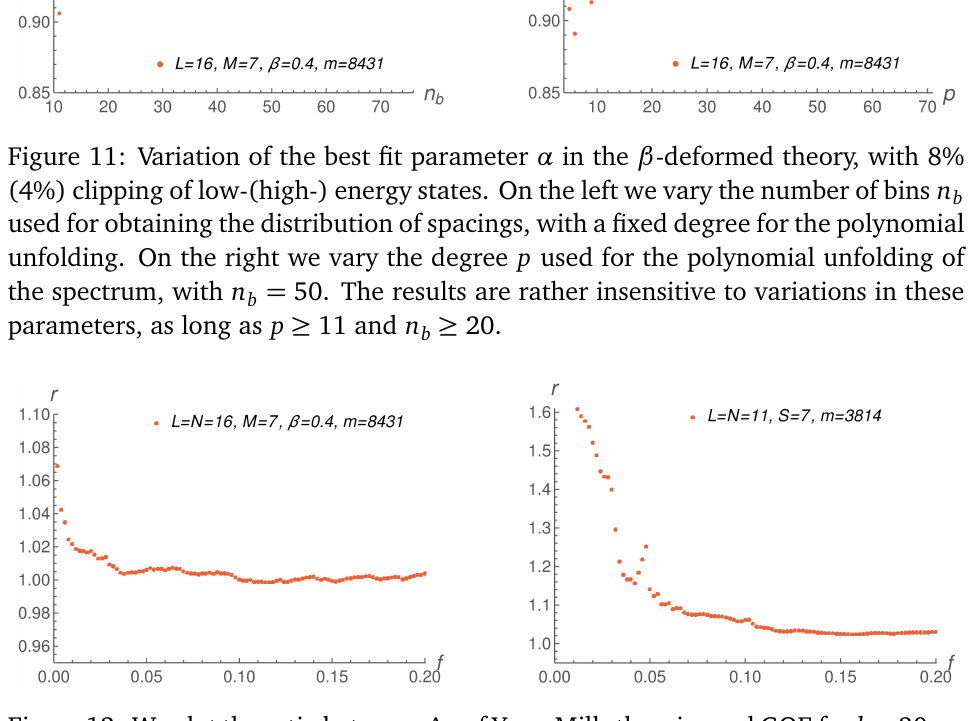
Figure 12: We plot the ratio between ∆ of Yang-Mills theories and GOE for l = 30, as 3 we vary the clipping fraction. On the left we show the su ( 2 ) sector of the β -deformed theory, while on the right we plot the sl ( 2 ) sector of the undeformed theory. Just as in the context of the spacing distribution, the undeformed theory requires a larger removal of states at the beginning of the